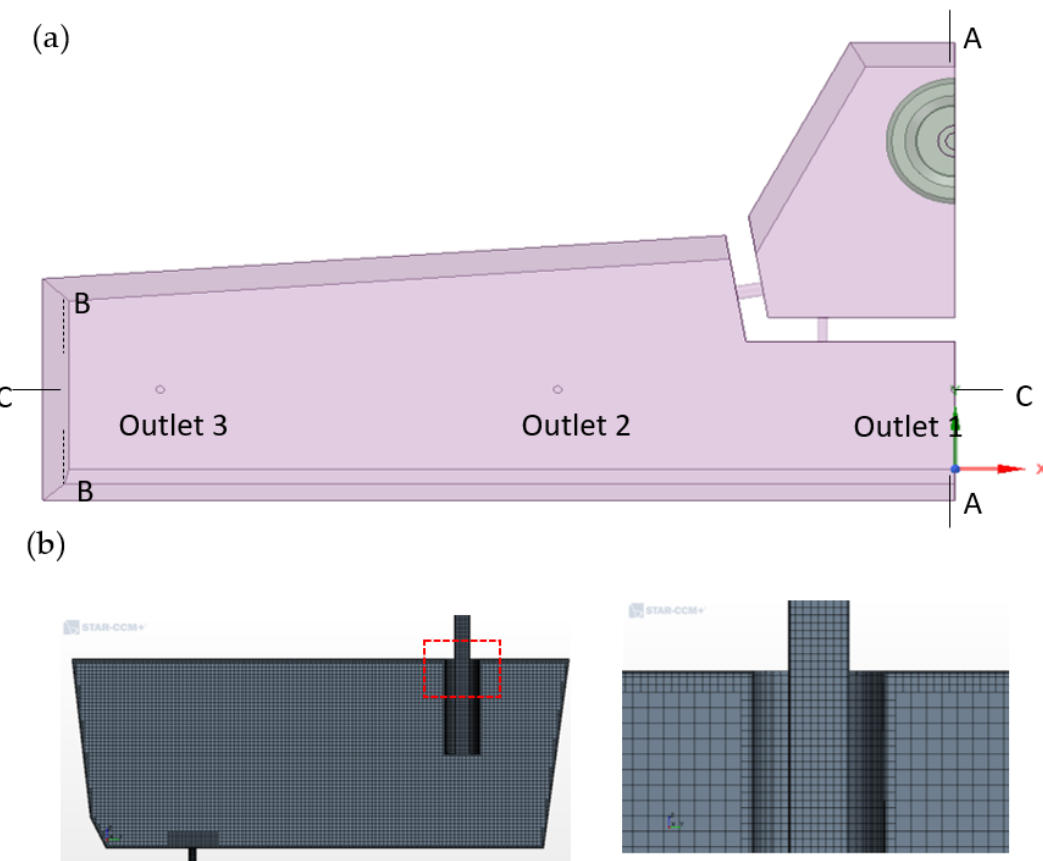
Figure 3. ( a ) Computational domain of numeric model (one ‐ half of the 5 ‐ strand tundish) ( b ) computational fluid dynamic (CFD) mesh on the symmetrical plane and zoom ‐ in